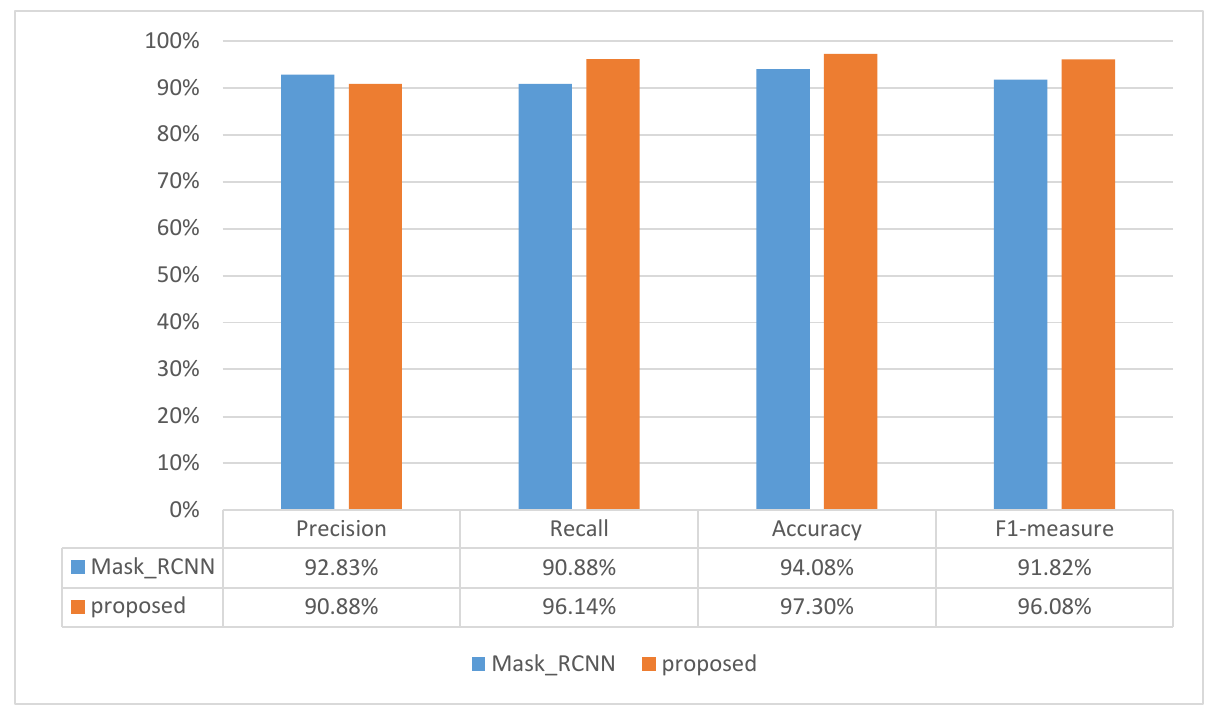
Figure 10. Comparison of Mask Region-Based Convolutional Neural Networks (R-CNN) and the proposed scheme.